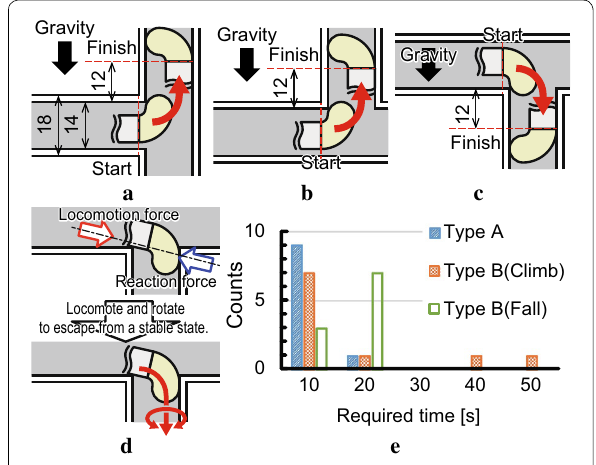
Fig. 16 Time required to pass through a branch. a – c The experimental setups. d The results